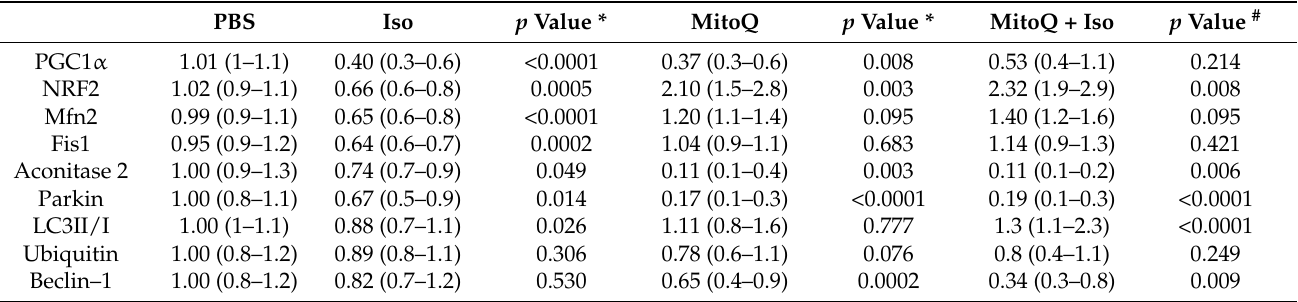
Table 3. Quantification of the mitochondrial biogenesis and autophagy/mitophagy in hypertrophied neonatal rat cardiomyocytes (NCMs) with or without MitoQ